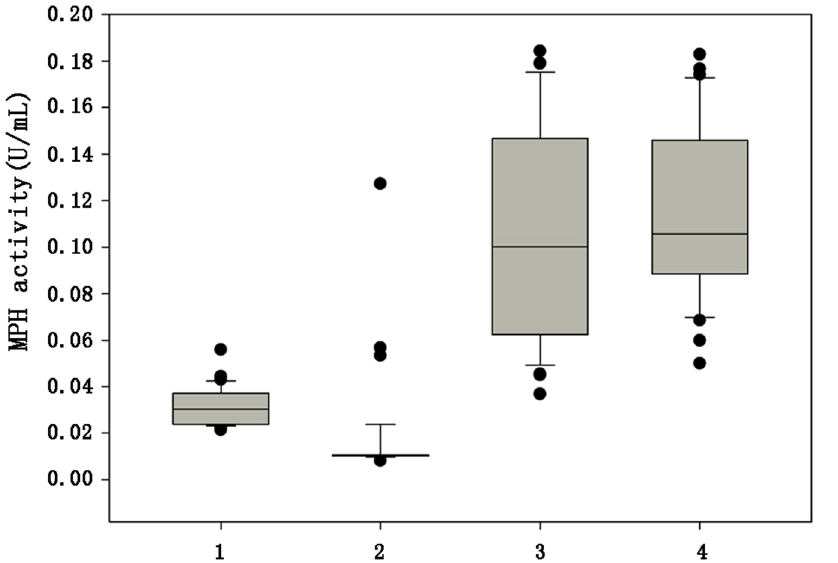
Figure 2. A box-whisker plot of enzyme activity in the culture supernatants of P.pastoris transformants . Boxes denote the interquartile range (IQR) between the first and third quartiles, while the line inside the box denotes the median. Whiskers denote the lowest and highest values within 1.5-fold the IQR from the first and third quartiles, while circles denote outliers. 1= P. pastoris clones that expressed MPH, 2=N 66 -MPH, 3=D